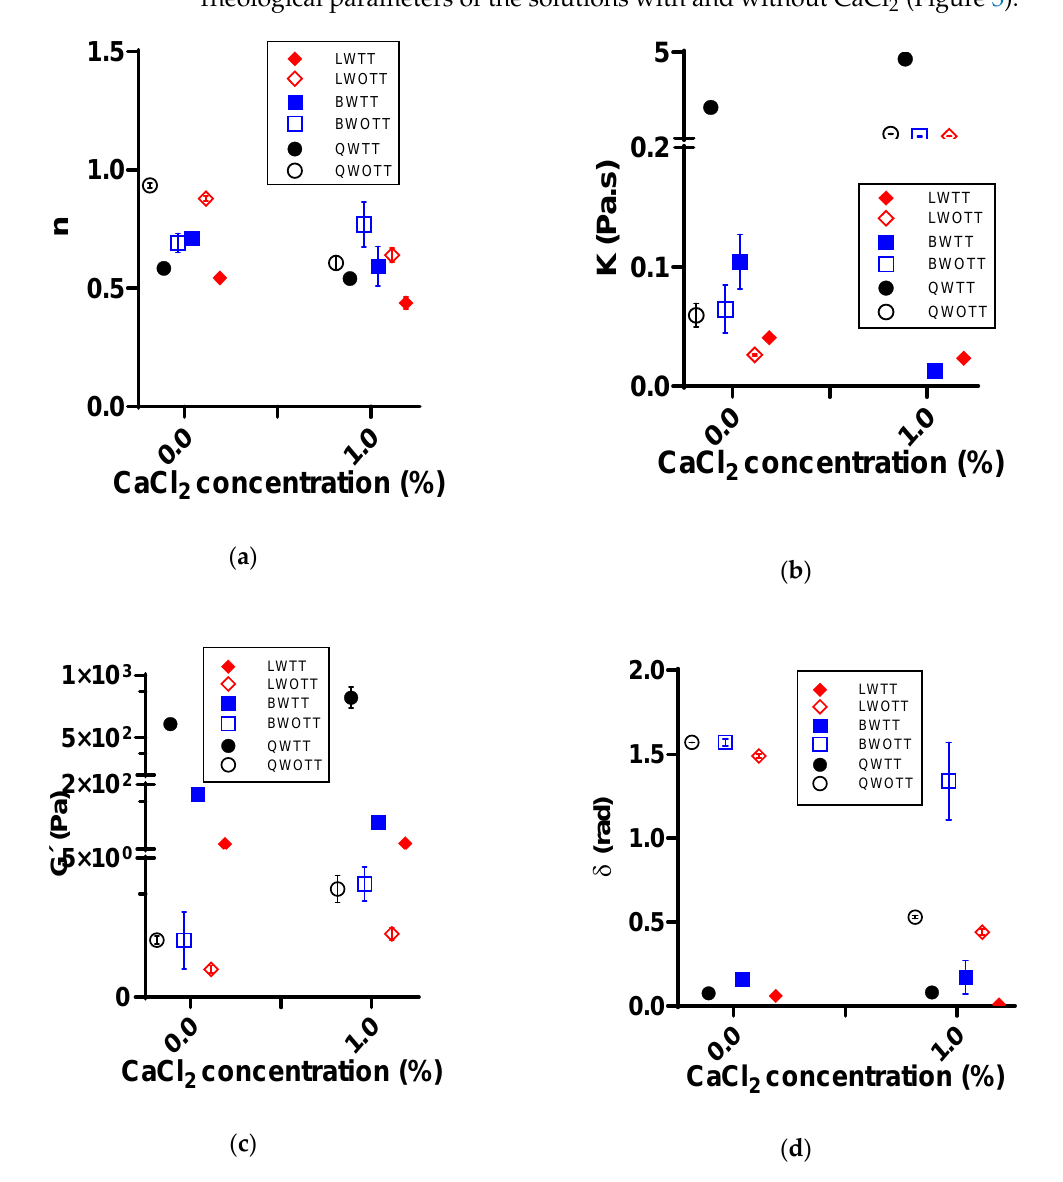
Figure 3. Effect of Ca 2+ and thermal treatment in protein concentrates on the rheological properties of solutions prepared with quinoa protein concentrates with heat treatment (QWTT) and without heat treatment (QWOTT); black bean protein concentrates with heat treatment (BWTT) and without heat treatment (BWOTT); and lentil protein concentrates with heat treatment (LWTT) and without heat treatment (LWOTT). ( a ) Average flow behavior ( n ) of the solutions; ( b ) average consistency index (K) of solutions; ( c ) average storage module (G’) of the frequency sweeps; ( d ) average phase shift angle ( δ ) of the frequency